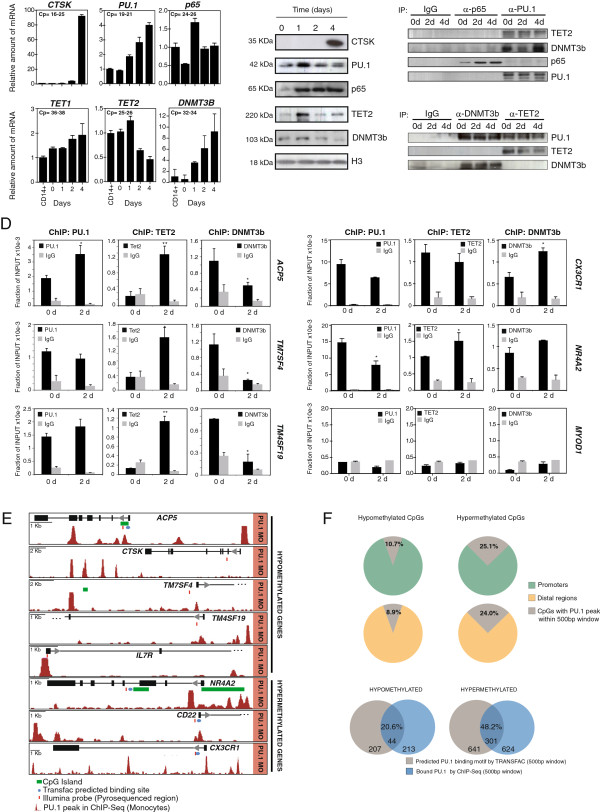
Interactions between PU.1 and DNTM3b and TET2 and association with promoters undergoing DNA methylation changes. (A) Quantitative RT-PCR analysis for CTSK, PU.1, p65 NF-kB, TET1, TET2, and DNMT3B during osteoclastogenesis. (B) Western blot for the same factors indicated above. (C) Immunoprecipitation experiment of p65 and PU.1 with DNMT3B and TET2 at 0, 2, and 4 days after RANKL and M-CSF stimulation. IgG used as a negative control. Reciprocal immunoprecipitation experiments in the bottom panel. (D) Quantitative ChIP assays showing PU.1, TET2, and DNMT3b binding to hypomethylated genes (ACP5, TM7SF4, TM4SF19) and hypermethylated genes (CX3CR1, NR4A2), all direct PU.1 targets, and a negative control (MYOD1 promoter) without PU.1 target sites. The experiment was performed with three biological triplicates but only one experiment is shown. T-student test comparing binding of each antibody between 0 days vs. 2 days was performed: * corresponds to P value <0.05; ** means P value <0.01; *** means P value <0.001. (E) Examples showing PU.1 binding (from ChIPseq data, GSE31621) to the region neighboring hypo- and hypermethylated CpGs. The PU.1 binding motif location is presented as a horizontal blue dot and the CpG displaying differential methylation (Illumina probe) between MO and OC is marked with a red bar. (F) Analysis of ChIPseq analysis for PU.1 and comparison to TRANSFAC predictions. Top panel: proportion of the CpG-containing probes displaying DNA methylation changes that have peaks for PU.1 binding in the same 500-bp window. Diagrams are separated in the hypo- and hypermethylated sets and in promoter and distal regions (gene bodies, 3′UTR, and intergenic regions). Bottom panel, Venn diagrams showing the overlap of PU.1 targets from ChIPseq data (GEO accession number: GSE31621) in MOs and TRANSFAC prediction for PU.1, both using a window of 500 pb centered by the CpG displaying significant methylation changes.